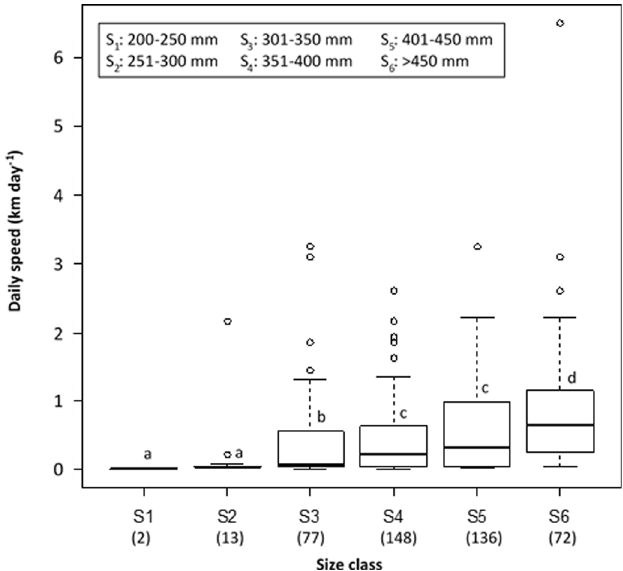
Fig. 6. Relations between the size classes of eels and the daily travel speeds. Numbers in brackets indicate the sample size of the eels detected. Values are medians, 5th, 25th, 75th and 95th percentiles; the bar marks the median and circles indicate outliers. Size classes marked with the same letter are not signi fi cantly different (H and W tests, p <